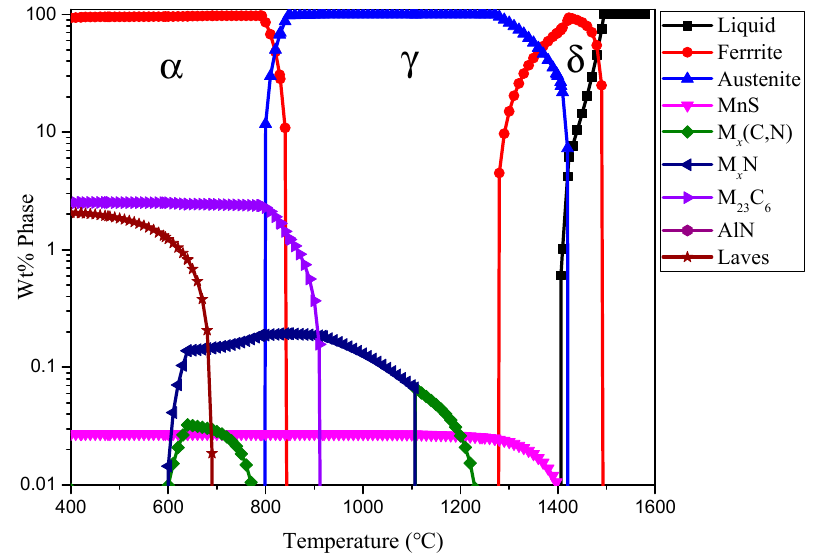
Figure 8. Relationship between the phases of CB2 FHRS and temperature.